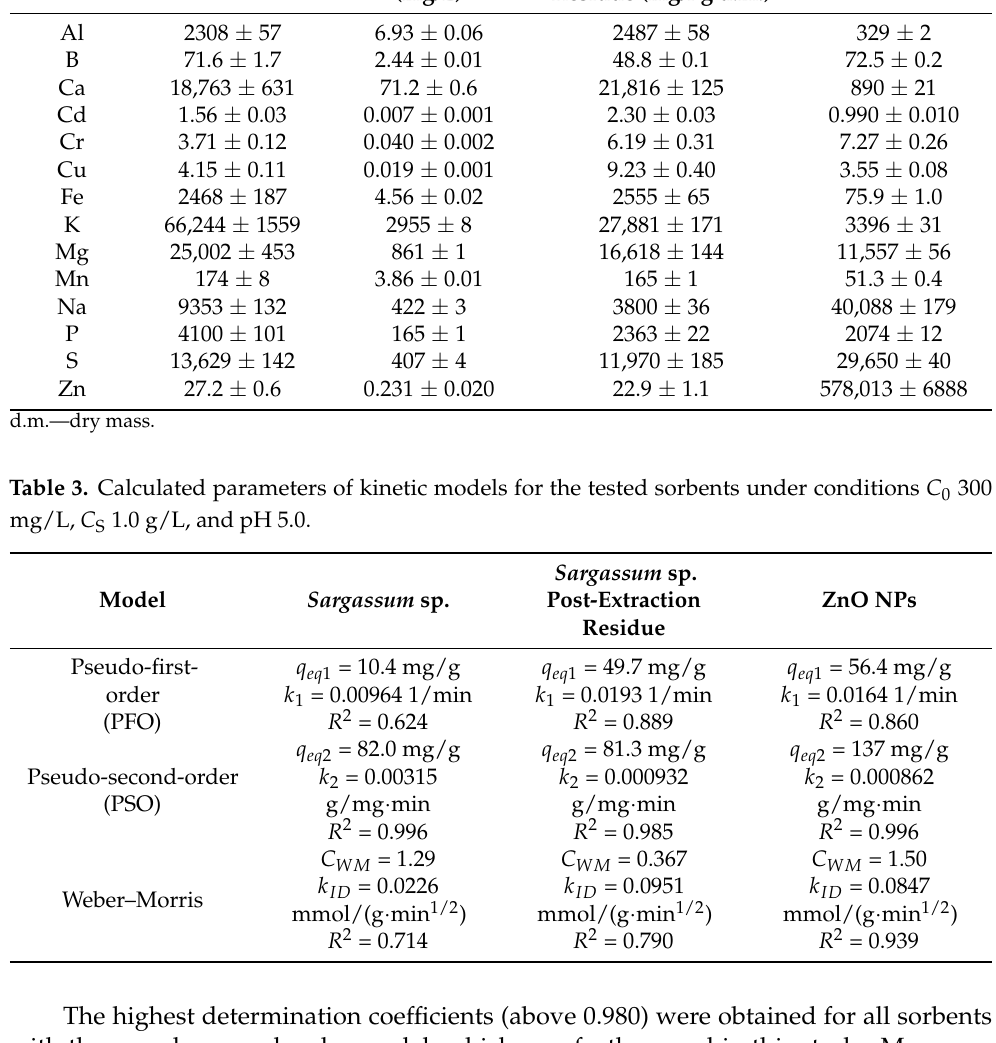
ZnO NPs (mg/kg d.m.)